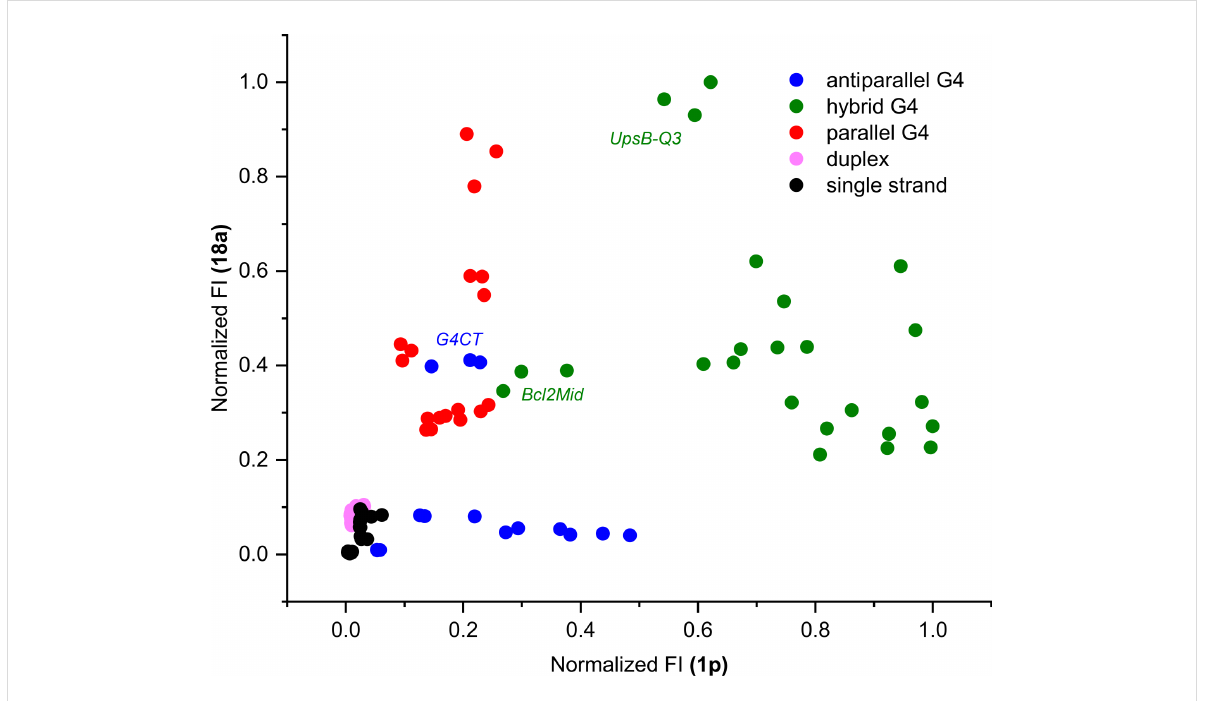
Figure 8: Dual-dye conformational analysis of an extended panel of 33 DNA oligonucleotides. This is performed on normalized datasets (data refer- ring to each of the two dyes are normalized separately), plotting the resulting fluorescence of compound 18a against that of compound 1p . Data for each target are presented as independent triplicates.